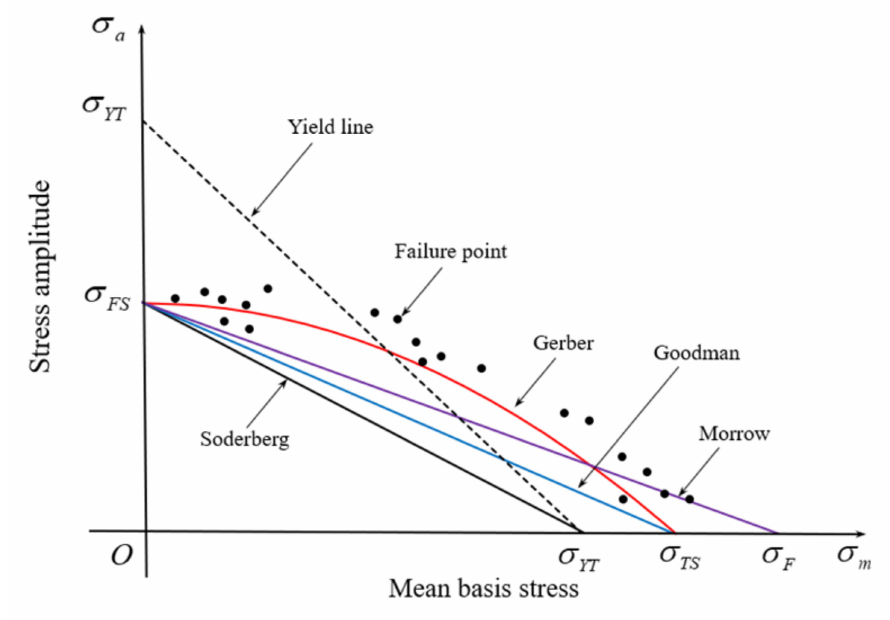
Figure 9. Effect of the mean stress on the equivalent fatigue strength curve